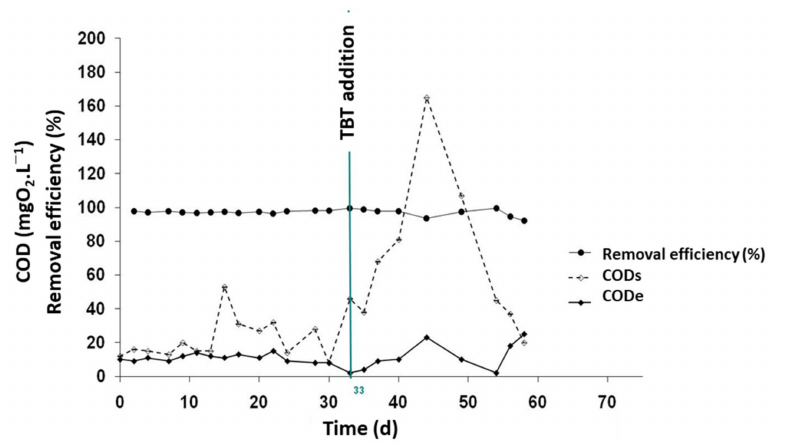
Figure 5. Evolution in soluble COD concentration (CODs), effluent CDO concentration (CODe) and COD removal efficiency in MBRi system.